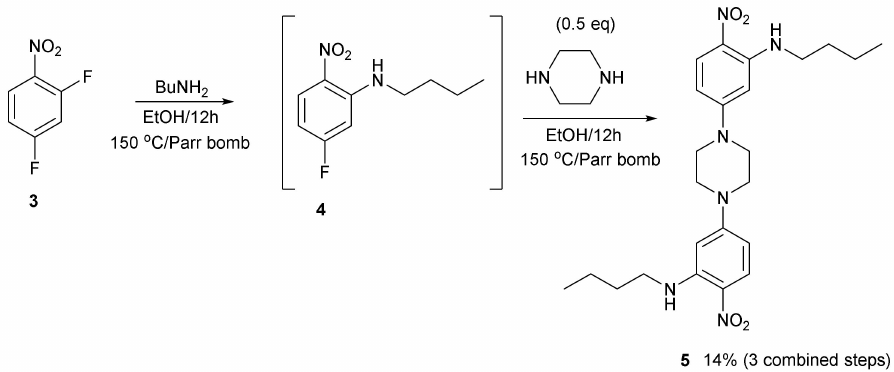
Figure 3. The synthesis of compound 5 .